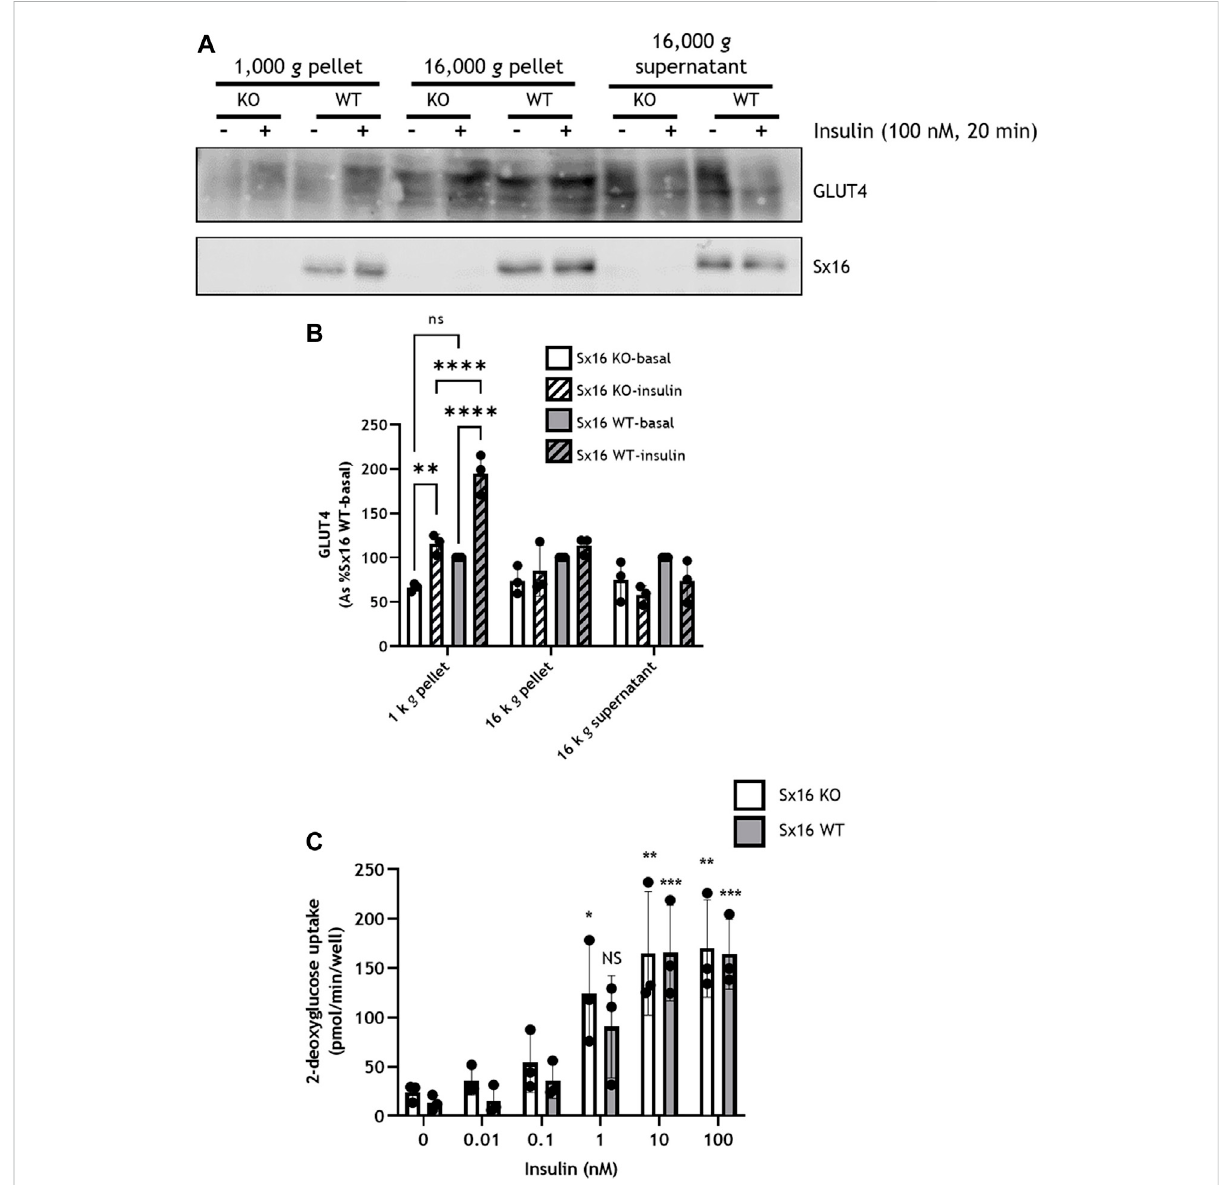
FIGURE 4 Insulin stimulated GLUT4 translocation but not glucose uptake was reduced in Sx16 knockdown cells. (A) Cell homogenates from Sx16- KO or WT cells were subjected sequential centrifugation to generate the 1,000 g pellet, 16,000 g pellet and the 16,000 g supernatant. The 1,000 g fraction is enriched for the PM and the 16,000 g supernatant is enriched in GSC/IRV (see text and Supplementary Figure S1). Representative immunoblots for GLUT4 and Sx16 are shown (B) Quanti fi cation of GLUT4 by densitometric analysis. Data is presented as % basal Sx16 wild type for each fraction from three independent experiments shown as mean ± SD. Signi fi cant effects of insulin on GLUT4 levels in the 1,000 g pellet are shown, together with signi fi cant differences between Sx16-KO and WT cells (** p < 0.01 and **** p < 0.0001 by two-way ANOVA; n.s. = not signi fi cantly different) (C) Glucose uptake was measured by the accumulation of 2-[ 3 H] deoxyglucose in cells treated with or without the indicated concentrations of insulin for 30 min as outlined. Each data point on panel C are the means of threebiological replicates ±SD(eachfrom triplicate technical replicates). No signi fi cantdifference wasobservedbetweenSx16knockout and Sx16 wild type cells under any condition. Signi fi cant effects of insulin are indicated by * p < 0.05, ** p < 0.01, *** p < 0.001; n.s. = not signi fi cantly